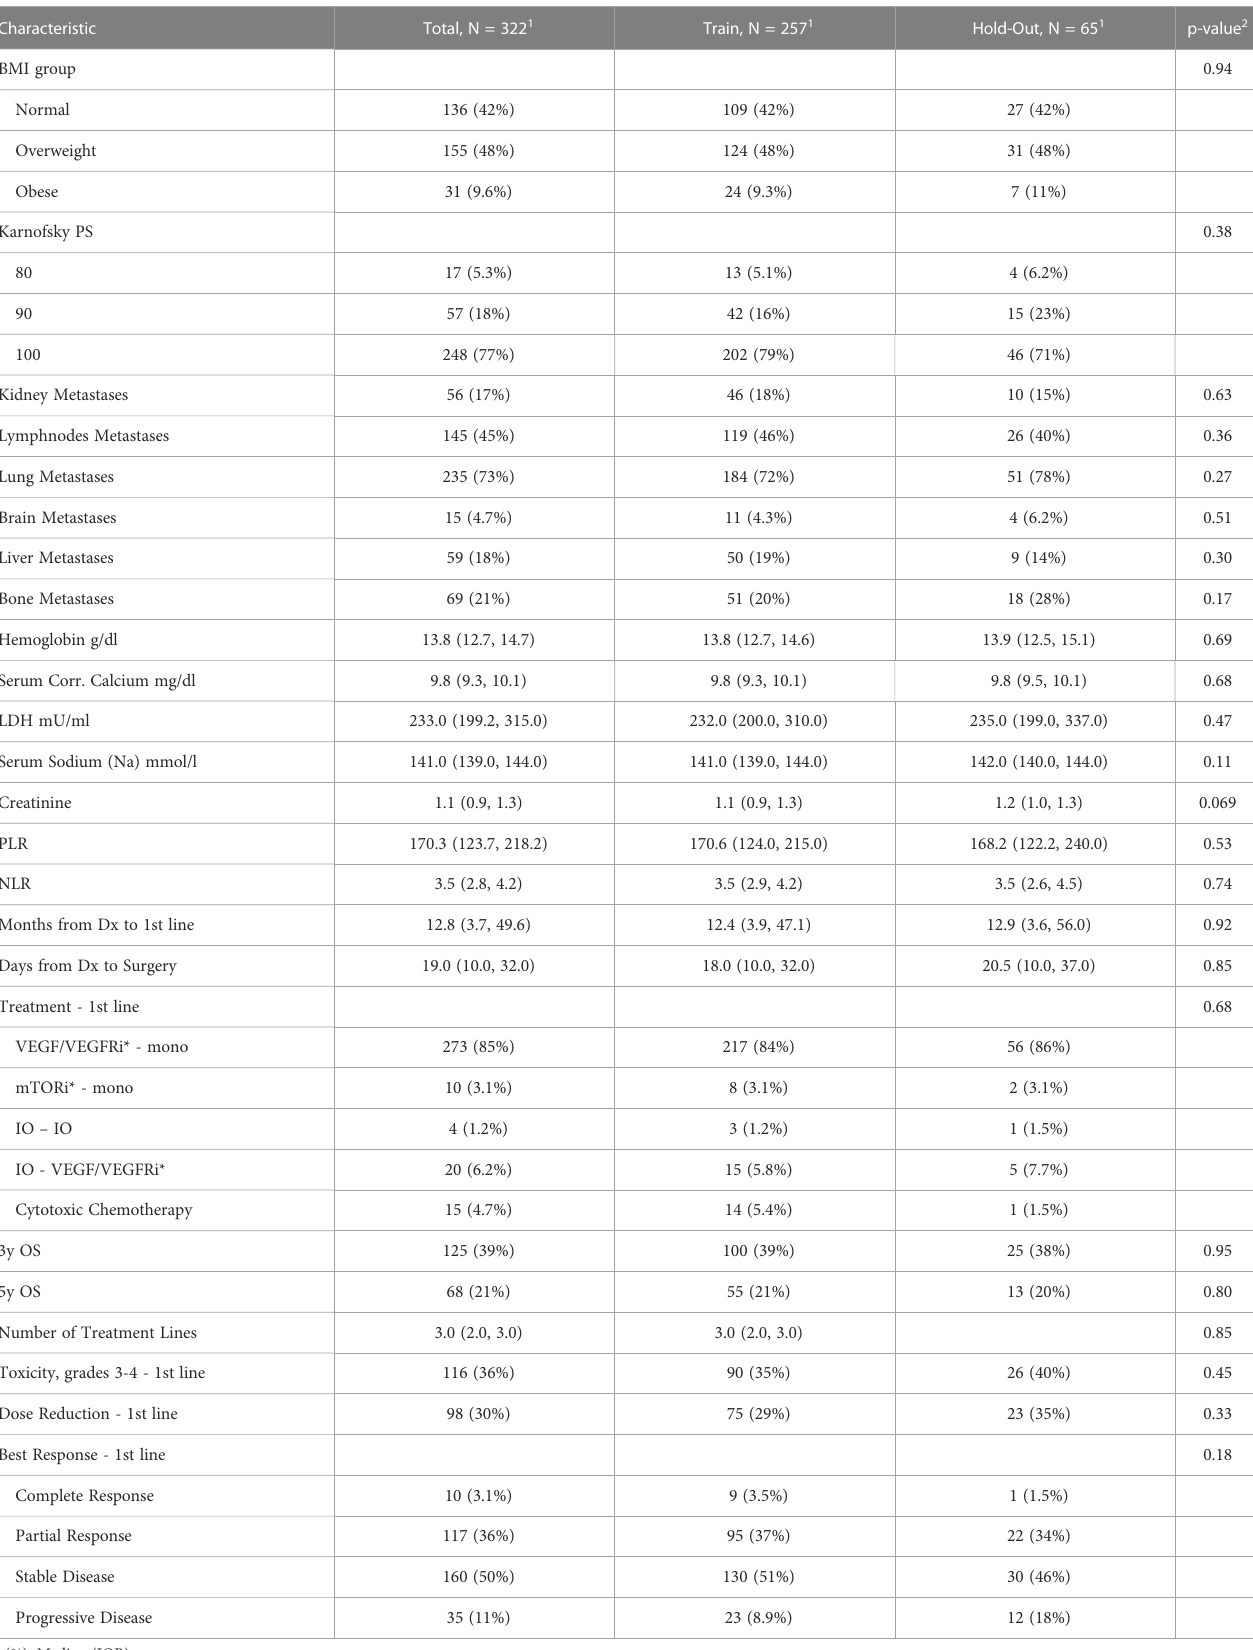
TABLE 1B The clinicopathological characteristics avaialable at start of the fi rst systemic treatment line and the outcomes for the RCC patients from this study.